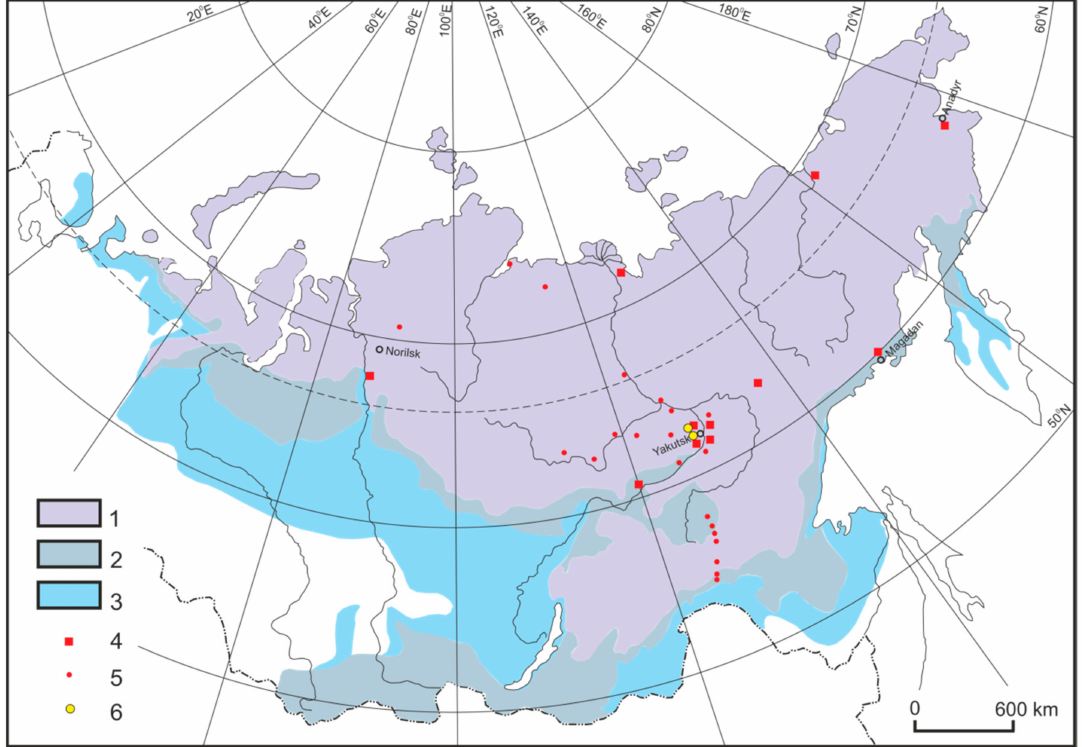
Figure 1. Map of monitoring sites for studying the thermal regime of the permafrost. Permafrost zones: 1–continuous; 2–discontinuous; 3–sporadic. 4–site with multiple monitoring points; 5–single monitoring point; 6–CALM